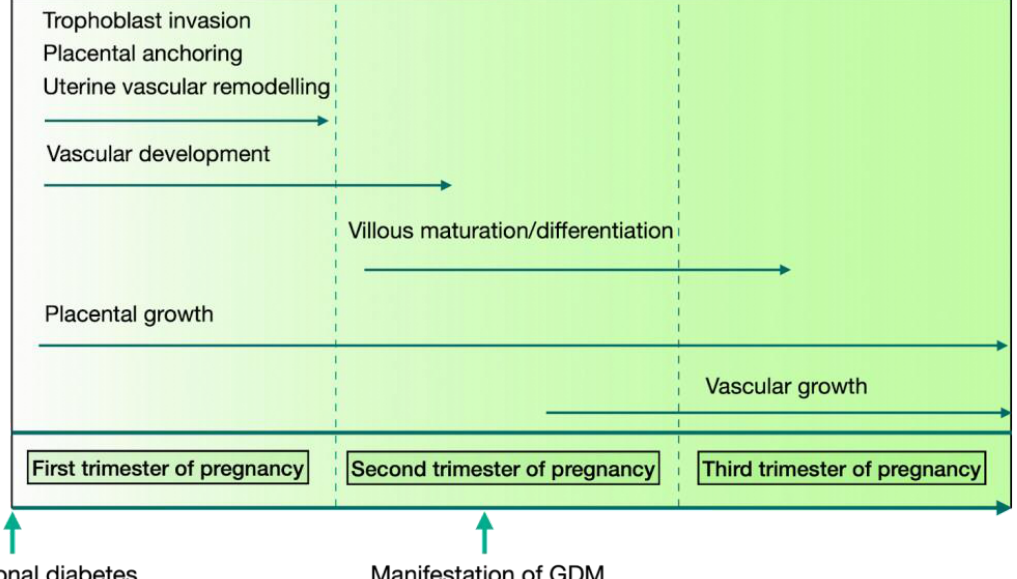
Figure 4. Illustration of placental development during pregnancy with designation of the timing of manifestation of pregestational diabetes (DM1, T2DM) and GDM.